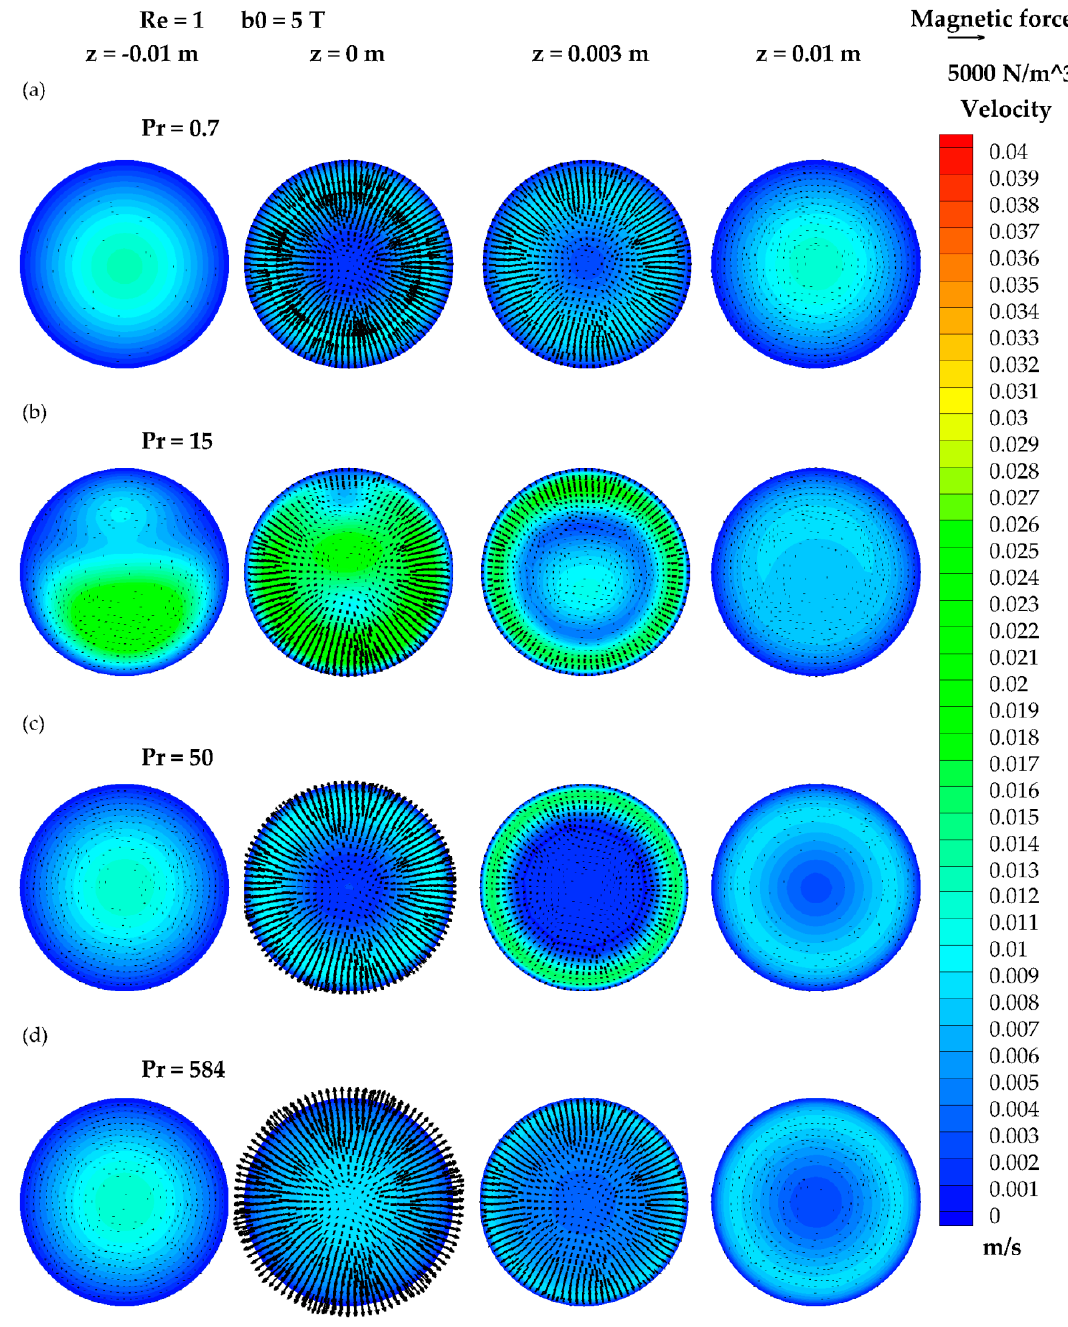
Figure 7. Flow structure in the radial cross-sections ( z = − 0.01 m, 0 m, 0.003 m, 0.01 m) at Re = 1 and b 0 = 5 T: ( a ) Pr = 0.7, ( b ) Pr = 15, ( c ) Pr = 50, ( d ) Pr = 584.